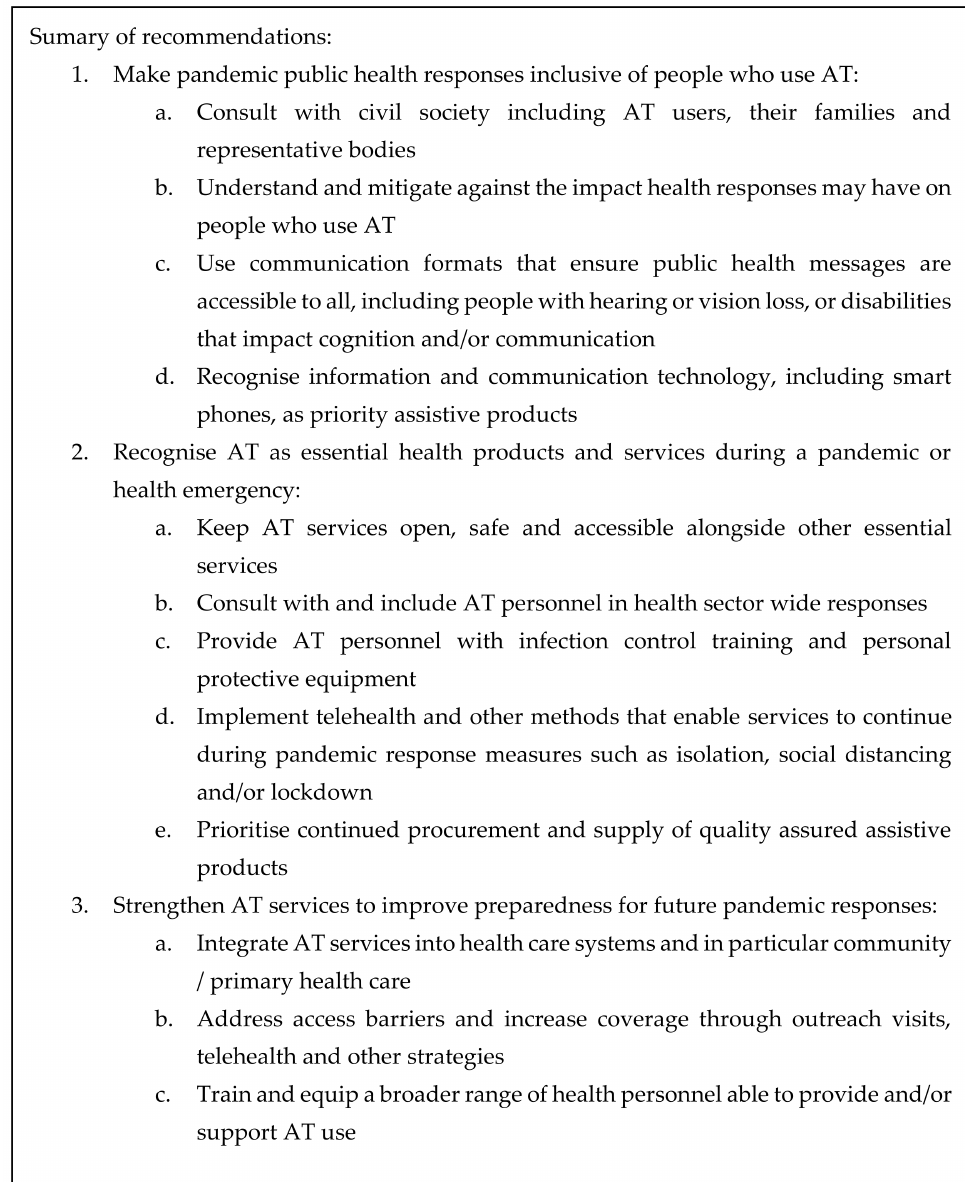
Figure 8. Summary of